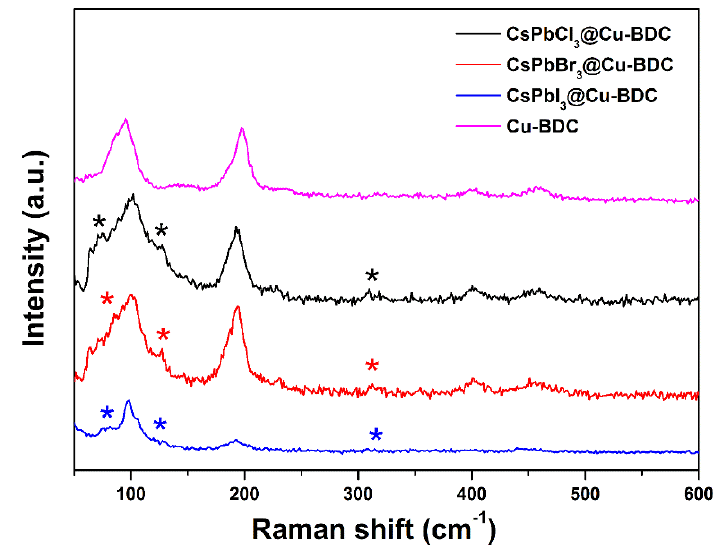
Figure 5. The Raman spectra of CsPbCl 3 @Cu-BDC, CsbBr 3 @Cu-BDC, CsPbI 3 @Cu-BDC and Cu-BDC. “*” represents the peaks.